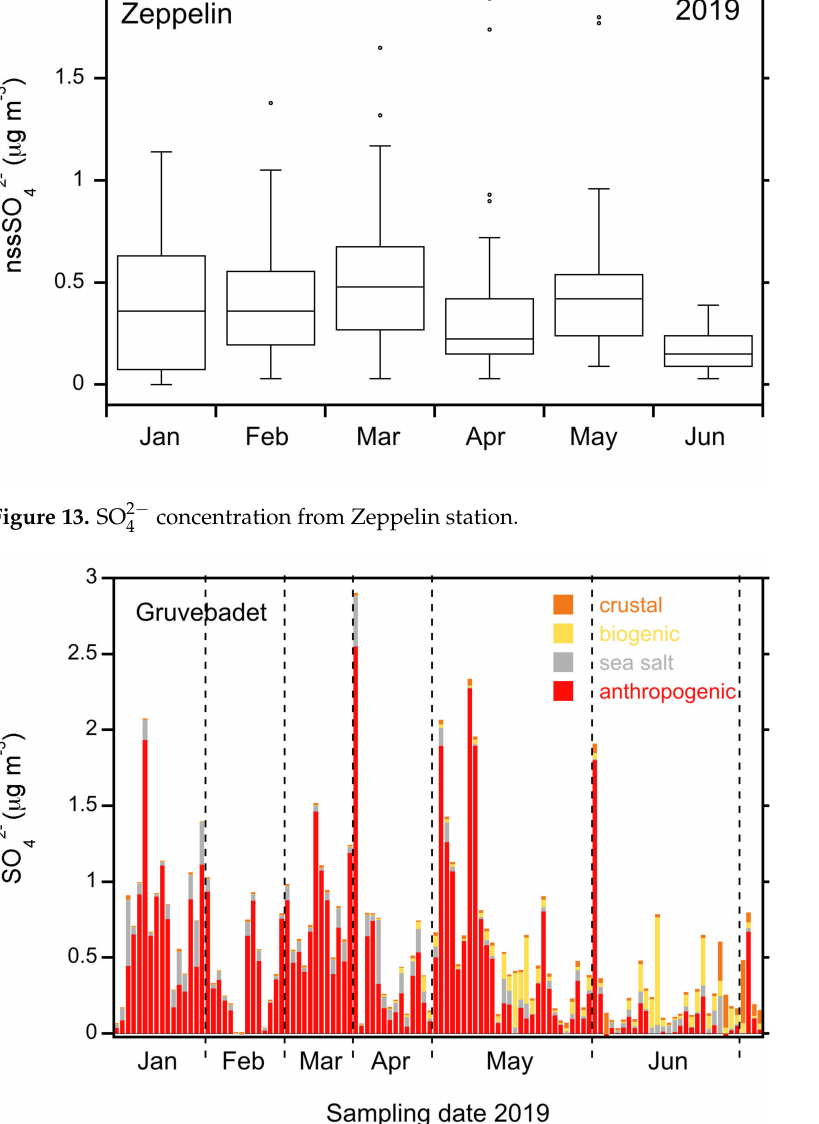
from Gruvebadet 4